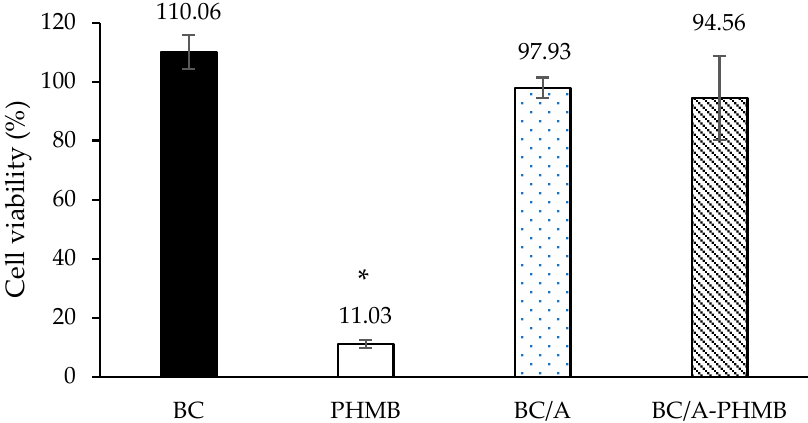
Figure 5. HaCaT cell viability after exposure to BC, PHMB, BC/A, BC/A-PHMB. The results are expressed as mean ± S.D. at a significant level of * p < 0.05 in comparison with BC/A.